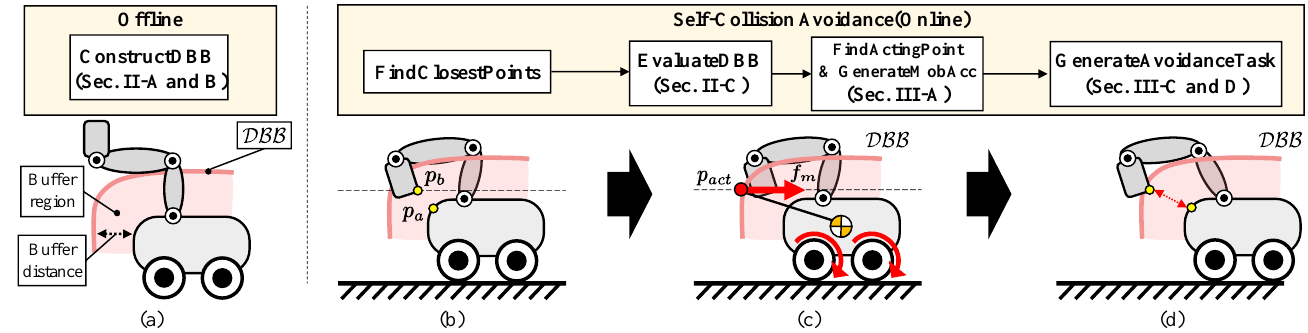
Figure 1. Overview of the proposed algorithm. ( a ) For each link colliding with the mobile robot, the DBB is defined as the boundary of the buffer region enclosing the mobile robot. ( b ) For example, when the distance between the manipulator and mobile robot is less than the buffer distance, the two closest points ( p a , p b ∈ R 3 ) are calculated. ( c ) To avoid self-collision, our strategy is to exert a force f m ∈ R 3 on the mobile robot to ensure that the manipulator lies outside the DBB. To accomplish this goal, a point on the DBB is selected as the acting point p act ∈ R 3 for the force after evaluating the 3D points on the DBB as scores. The target direction of the force is toward the closest point p b on the manipulator. ( d ) To realize the desired force and resulting torque, we construct the avoidance task by converting them to the accelerations for the mobile robot. As the task is continuously inserted into the controller, self-collision between the manipulator and mobile robot can be